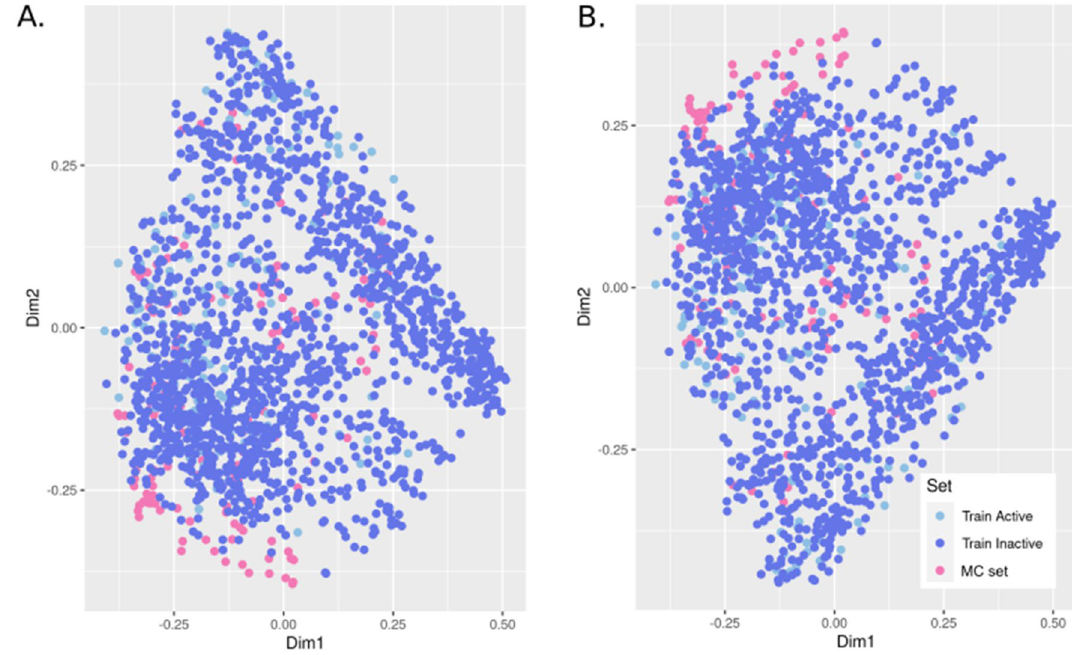
Figure 11. Projection of the MC chemicals set on the training set used to build the ( A ) QSAR-E2up model and ( B ) QSAR-P4up model. Projection is realized using a multidimensional scaling on the similarity matrix computed using a pair wise Tanimoto score from a MACSS fingerprint by